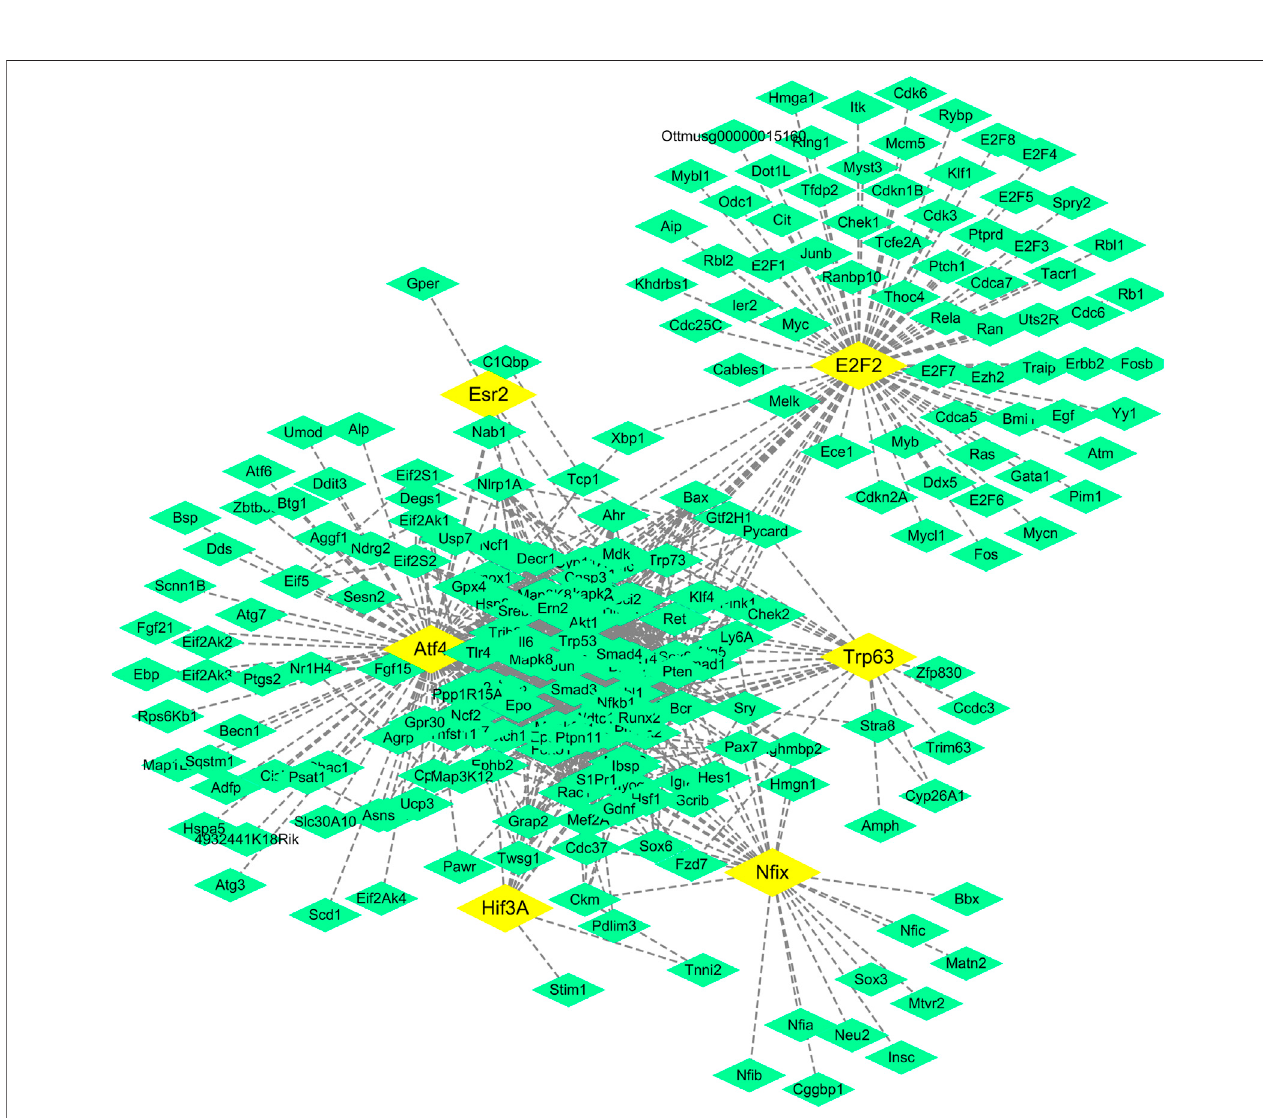
FIGURE4| Regulatorynetworkoftranscription factors and theirtarget genes.Notes:Theyellow boxesaretranscriptionfactors,thegreenboxesaretargetgenes.